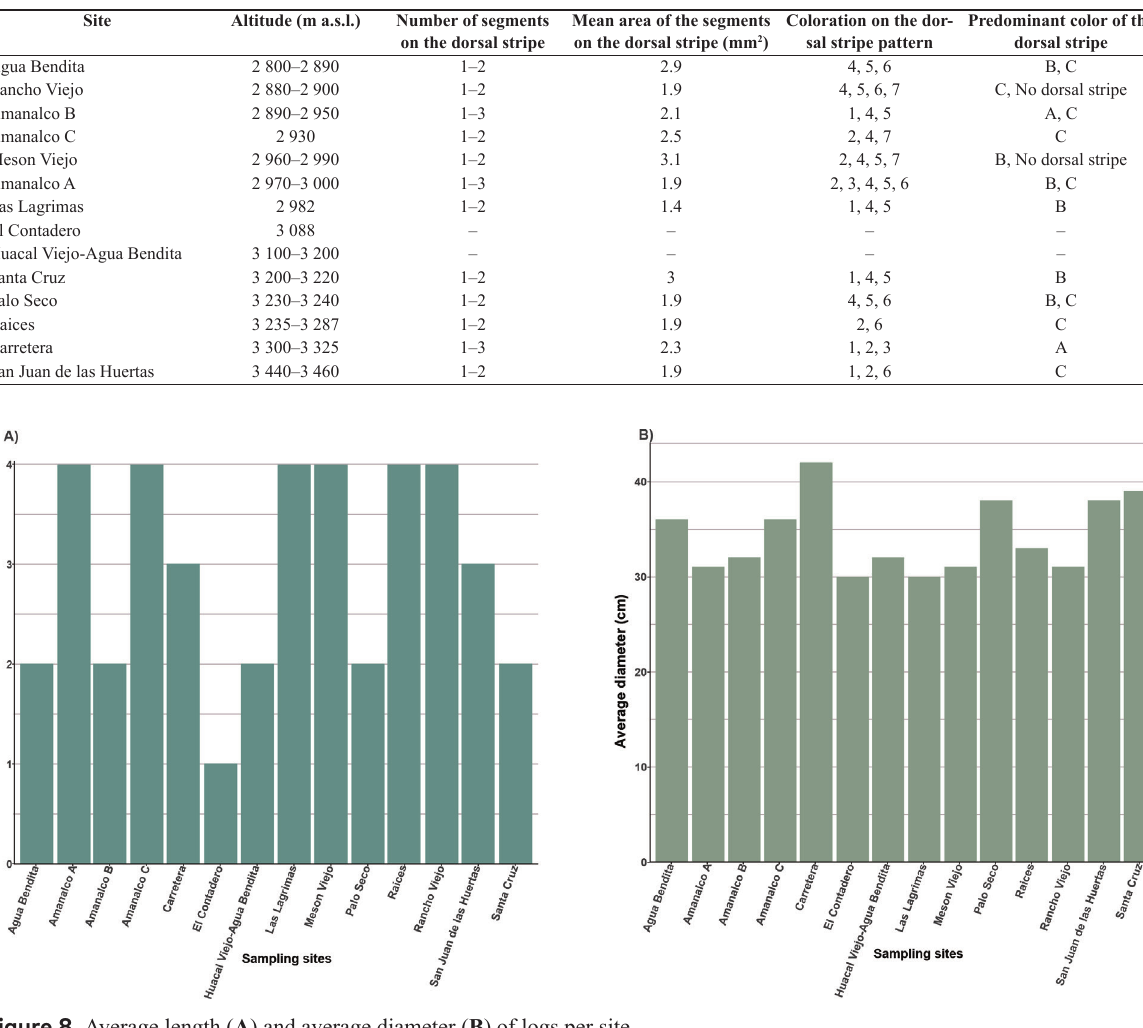
Mean area of the segments Coloration on the dor- Predominant color of the on the dorsal stripe on the dorsal stripe (mm 2 ) sal stripe pattern dorsal